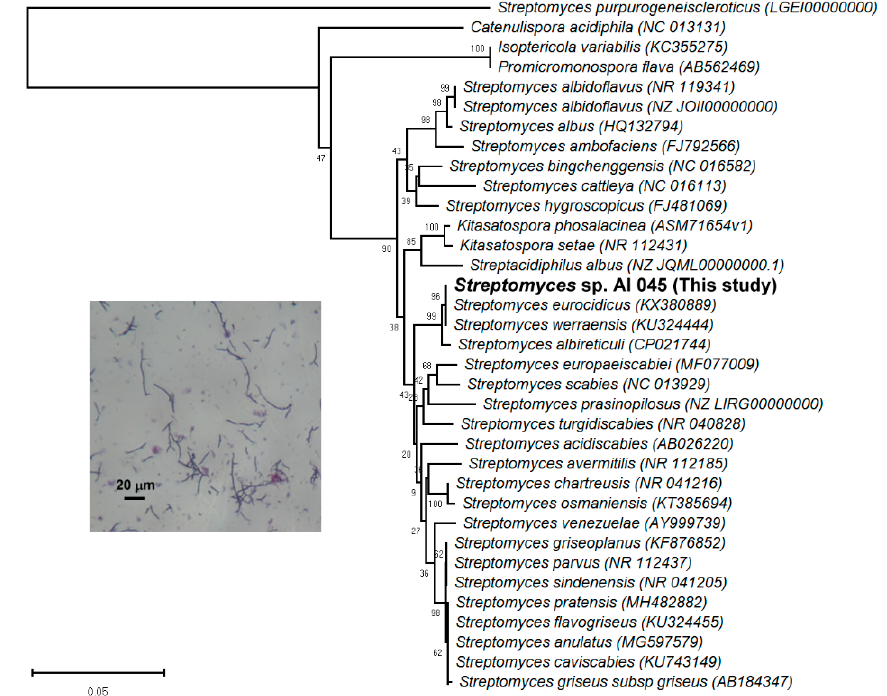
Figure 1. Molecular phylogenetic analysis of strain AI 045 and the other candidates with the neighbor-joining (NJ) method based on the general time reversible (GTR+G+I) model [17]. The optimal tree with the sum of branch length = 0.67102039 is shown. The percentage of replicate trees in which the associated taxa clustered together in the bootstrap test (500 replicates) are shown next to the branches [18]. The tree is drawn to scale, with the branch lengths in the same units as those of the evolutionary distances used to infer the phylogenetic tree. The evolutionary distances were computed using the maximum composite likelihood method [19], and are in the units of number of base substitutions per site. The rate variation among the sites was modeled with a gamma distribution (shape parameter = 0.76). The differences in the composition bias among sequences were considered in evolutionary comparisons [20]. The analysis involved 35 nucleotide sequences. All positions with less than 95% site coverage were eliminated. That is, no fewer than 5% alignment gaps, missing data, and ambiguous bases were allowed at any position. There were a total of 875 positions in the final dataset. Evolutionary analyses were conducted in Molecular Evolutionary Genetics Analysis (MEGA) X [21]. Gram staining revealed that strain AI 045 is a long, straight filament aerial hyphae, Gram-positive bacterium (see the inserted